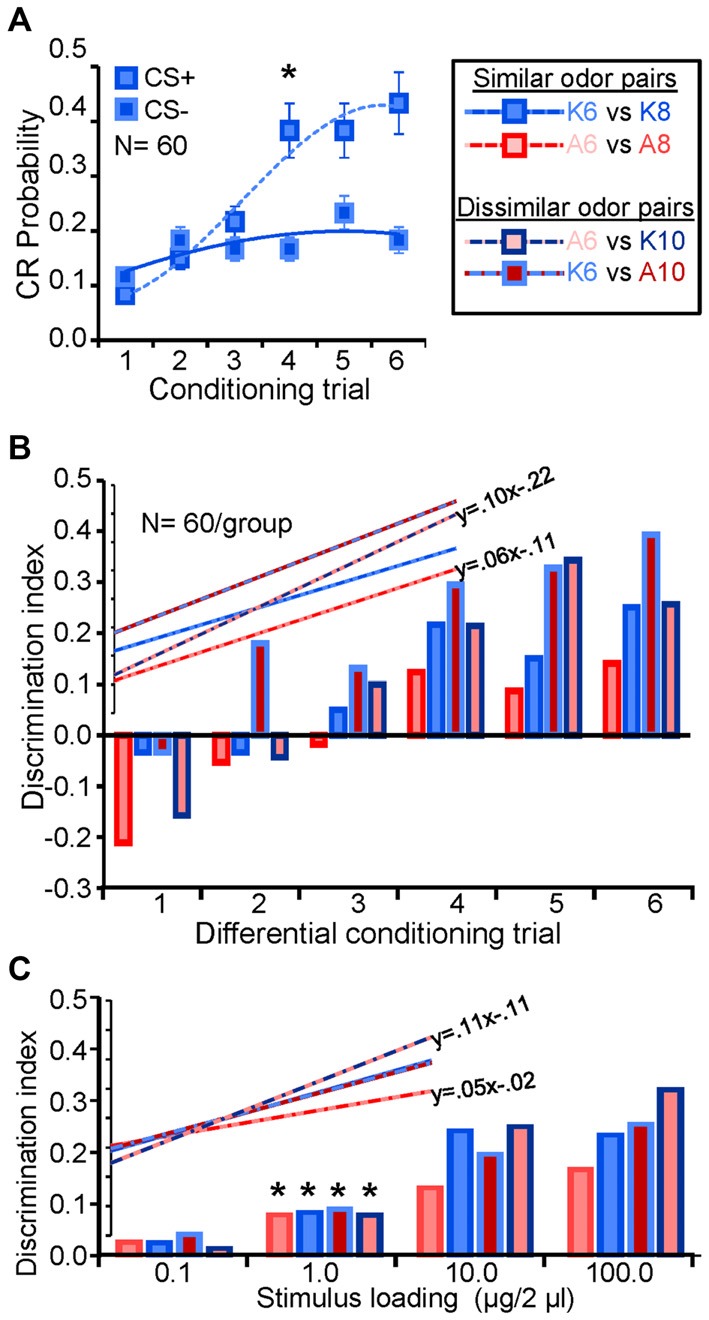
Consistent detection and discrimination thresholds. (A) Acquisition of the differential CR for K6 and K8. Both odors were used as the CS+ and CS− odorants and results were pooled as part of a counterbalanced design, hence results are presented as CS+ and CS−. Inset asterisks indicate the trial at which the CS+ and CS− produced a significant differential response (one tailed paired t-test; p < 0.05). Error bars represent the standard error. (B) Discrimination index as a function of successive conditioning trials for all four odor pairs used in this study. Bar outline and fill are color coded to identify the moiety (ketones = blue; alcohols = reds) and shaded to indicate carbon chain length (dark = 10; medium = 8; lite = 6) of the odorant pair. The discrimination index displays the mathematical difference between the CS+ and CS− responses by trial. Note that the initial negative values occur during conditioning because half of all of the first CS− conditioning trails were preceded by a CS+ trial which generalizes to the first CS− trial (see Daly et al., 2001a). Inset are the linear regression functions for each odor pair with the linear regression equations for the steepest and shallowest regression function; this highlights that A6 vs. A8 was the most difficult differential conditioning task to learn whereas A6 vs. K10 was the easiest. (C) Discrimination index as a function of stimulus loading (concentration) during the testing phase. The discrimination index in this case is the mathematical difference between the CS+ and CS− responses at each test loading. Results averaged across testing days. Significant difference between CS+ and CS− are highlighted by asterisks and indicate the lowest loading at which a significant differential response between the CS+ and CS− occurred (one tailed paired t-test; p < 0.05). Inset are linear regression functions for each odor pair as a function of loading. Also inset are corresponding regression equations for the steepest and shallowest functions, highlighting that A6 vs. A8 was the most difficult odor pair to discriminate whereas A6 vs. K10 was the easiest.